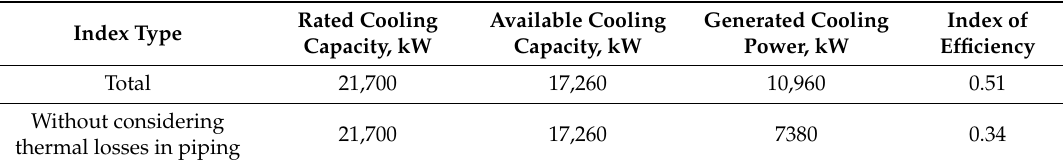
Table 3. Index of efficiency of the cooling systems under